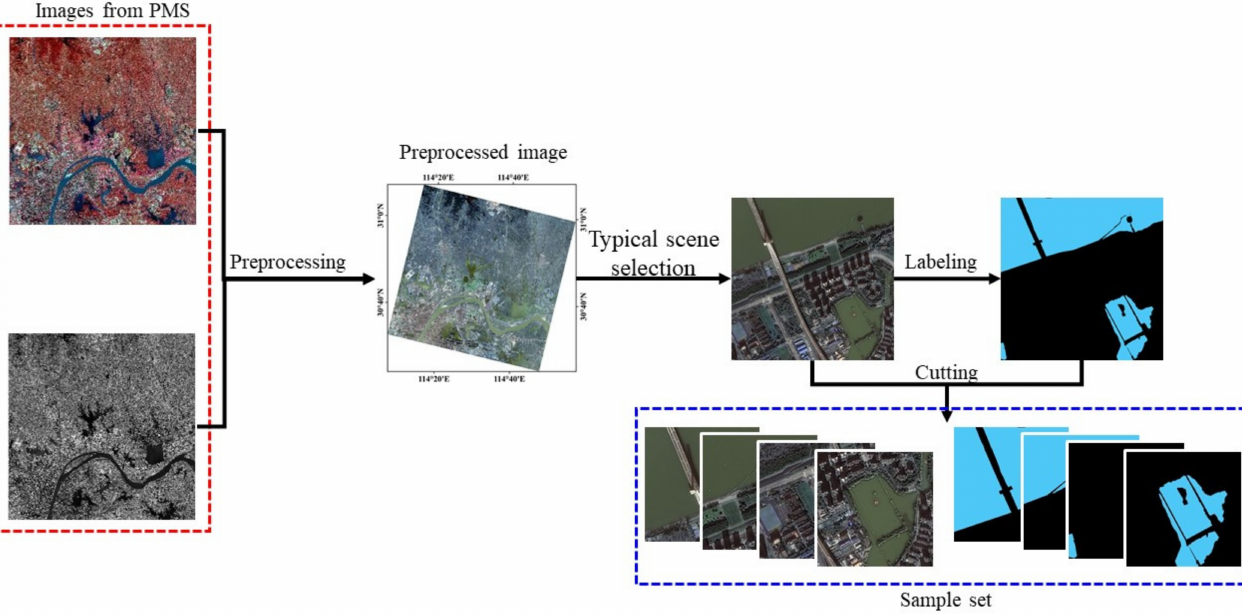
Figure 2. Steps of sample